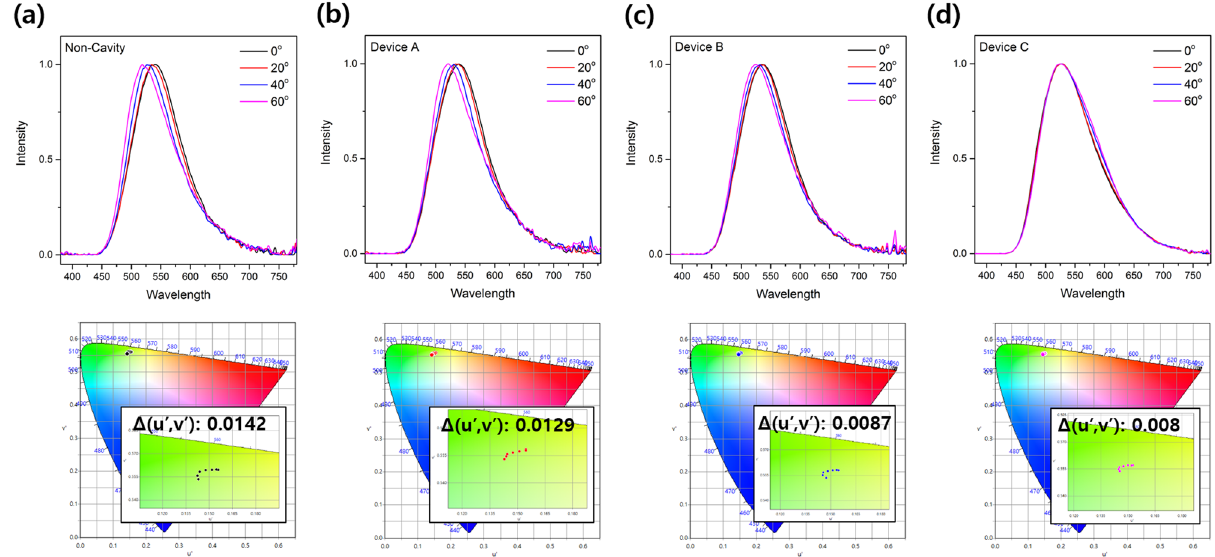
Figure 4. Viewing angle characteristics of the OLEDs with different diffusion layers (above: EL spectra, below: color coordinates according to viewing angle): ( a ) Non-Cavity device, ( b ) Device A ( c ) Device B, and ( d ) Device C.